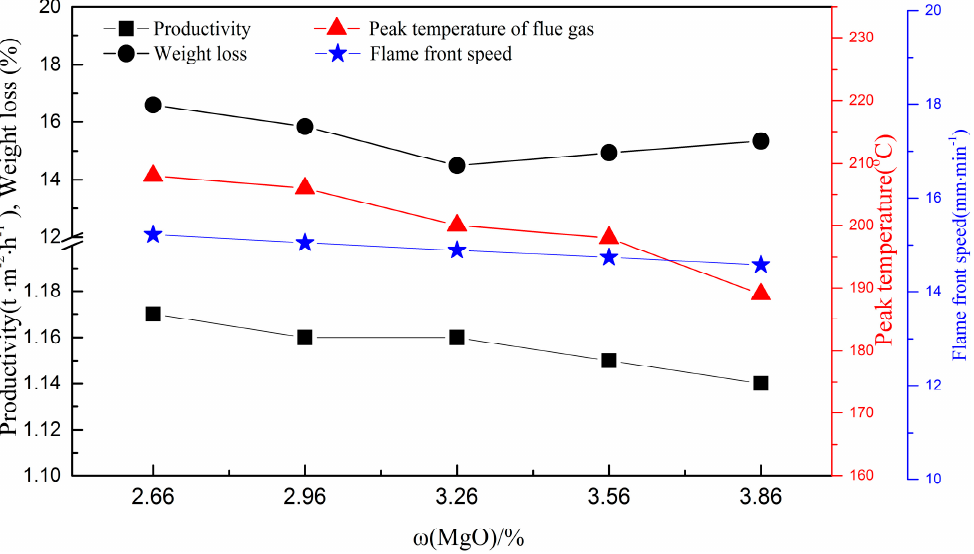
Figure 3. Effect of ω (MgO) on the CCVTM sintering process.